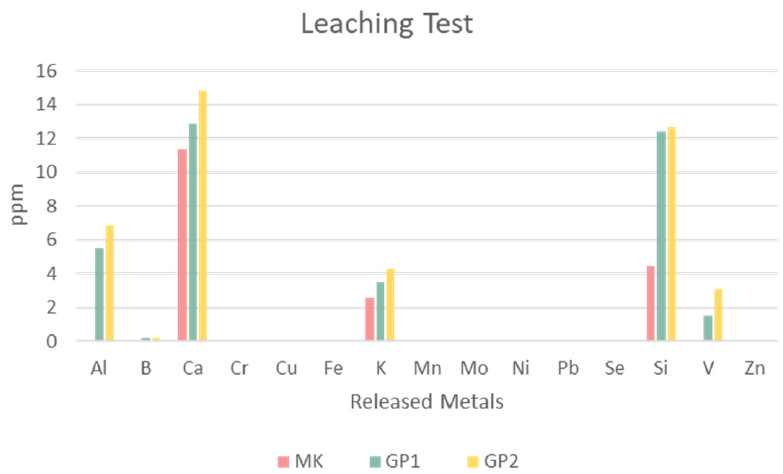
12 of 14 Figure 14. FT-IR spectra of: ( A ) GP1, BBGP1, CRGP1, PPTGP1, and MOGP1; ( B ) GP2, BBGP2, CRGP2, PPTGP2, and MOGP2 extracted at 56 days of ageing times and compared with the MK spectrum. 3.1.4. Leaching Test Figure 15 reports the values in parts per million of the heavy ionic metals released by MK, GP1, and GP2. The histogram reveals that the main elements released were Al, Ca, K, Si, and V, their amounts being proportional to the content, except for silicon. The pre- cursor MK released a low amount of these metals; there was a growing amount of released